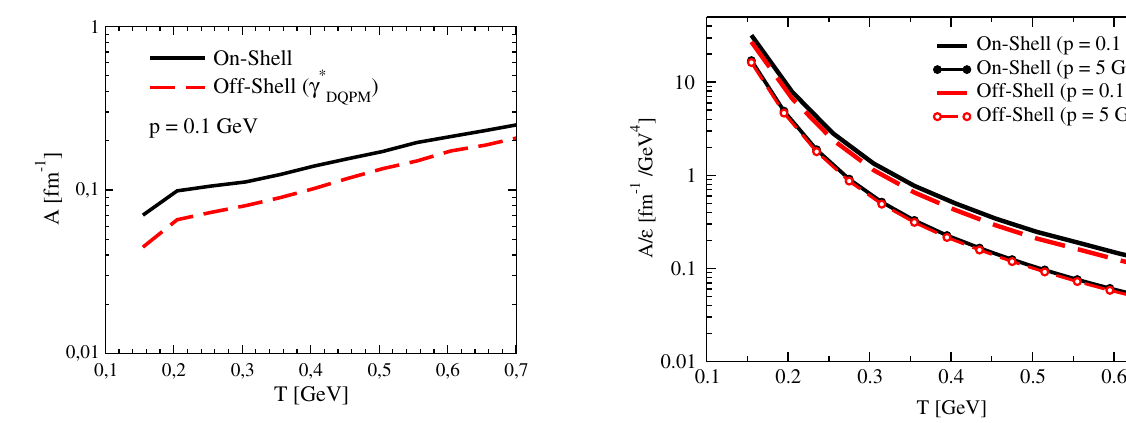
bulk system, the decrease of coefficient in off-shell case